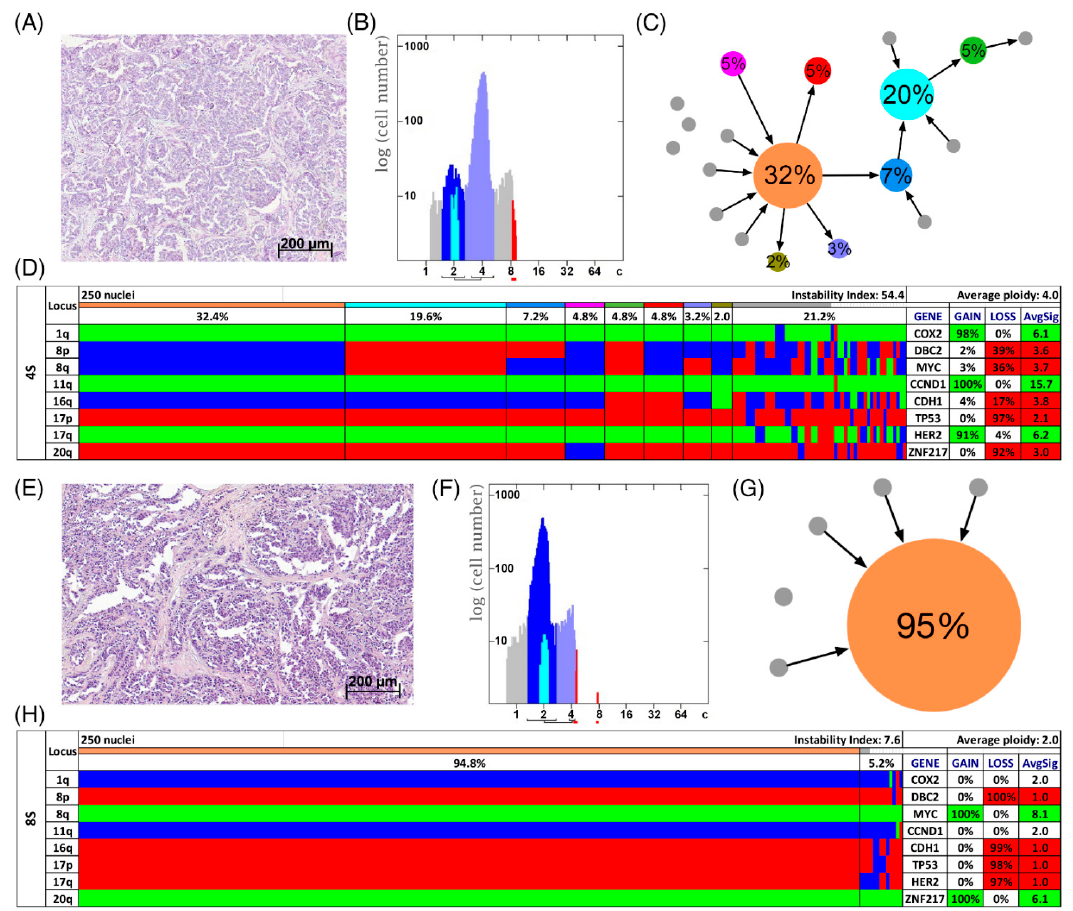
Figure 4. Patients with short survival. Histology ( A , E ), image cytometry ( B , F ), imbalance clone plots ( C , G ) and miFISH results ( D , H ) for the cases 4S ( A – D ) and 8S ( E – H ). ( A , E ) Sections of the respective breast cancer samples showing the histomorphology based on H&E staining. ( B , F ) DNA histograms showing the quantitative measurements of the nuclear DNA content assessed by image cytometry using Feulgen-stained cytospins. For quantitative measurement of the DNA content the sample was screened for several diploid nuclei (granulocytes, lymphocytes) to set the 2c value indicating a diploid DNA content. The quantitative measurements of the nuclear DNA content (x axis) of the tumor cells given in ‘c’ units were then calculated accordingly [18]. The y axis represents the total cell count. In case 4S 5810 and in case 8S 6721 nuclei were analyzed. ( C , G ) Imbalance clone plots visualizing the clonal composition of the analyzed breast cancer section and their putative evolutionary trajectory. The area of the circles correlates with the frequency of a cell-clone with a specific gain-and-loss pattern within the tumor cell population. Clones derived by a single gain or loss change are connected by arrows. The arrows indicate the clonal evolution according to gain-and-loss patterns in the color charts ( D , H ) starting from the clone with the fewest gains and losses. Thus, unconnected clones must differ in more than one gain or loss in their gain-and-loss pattern. Color coding allows assignment of the individual clones to the corresponding clones in the color charts in D and H. ( D , H ) Color chart of miFISH analysis with 8 gene-specific probes. Copy number counts for each nucleus are displayed as gains (green), losses (red) and neutral (blue). Markers are plotted vertically with the ‘Locus’ column depicting the specific chromosome arm for each probe on the left of the plot, and the corresponding gene name on the right. Nuclei are plotted horizontally by pattern frequency. Each vertical line discerns specific gain-and-loss patterns and the prevalence of the cell clone in the tumor population. Copy number gains and losses are depicted as percentages of the total cell population in the ‘Gain’ and ‘Loss’ column of the table on the right. Color-labeled percentages indicate a threshold of 15%. The column ‘AvgSig’ refers to the average of all signal numbers specified for each of the 8 analyzed gene probes. In order to quantify the frequency of altered clone patterns as a reflection of tumor heterogeneity, the instability index ( I ) of each case was calculated according to the following formula with N being the number of signal patterns observed and n as the number of nuclei analyzed